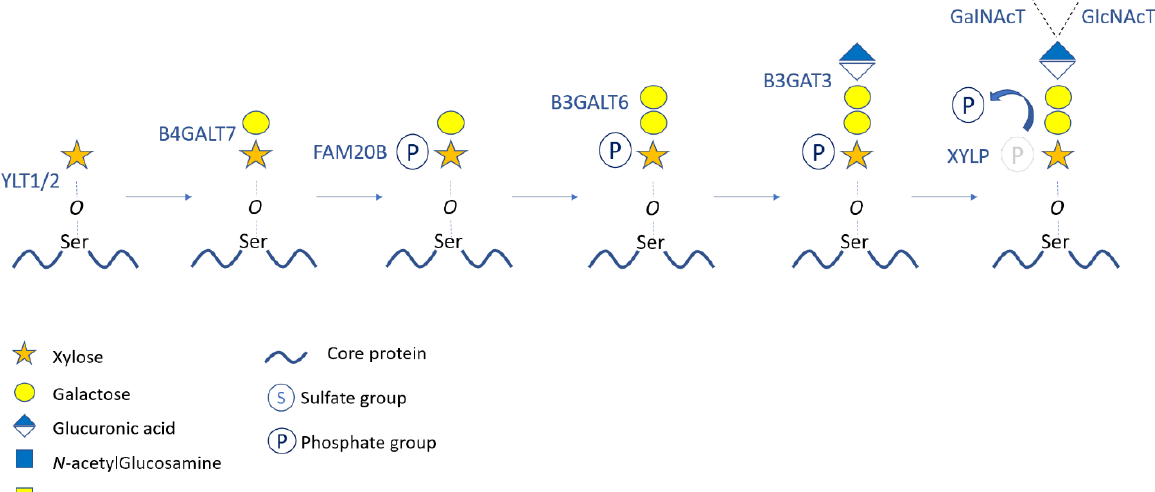
Figure 2. Biosynthesis and modifications of the tetrasaccharide linkage region. The successive steps of the initiating tetrasaccharide biosynthesis and modifications are represented with the corresponding enzymes. Transfer of the first aminosugar of CS or HS chains is also illustrated. The transient phosphorylation of the xylose occurs after the first Gal addition and is removed before the first aminosugar transfer. Enzyme abbreviations: XYLT: Xylosyltransferase; B4GALT7: β -4- galactosyltransferase7; FAM20B: Family with sequence similarity 20B; B3GALT6: β -3- galactosyltransferase6; B3GAT3: β - 3-glucuronyltransferase3; XYLP: xylose phosphatase; GalNAcT: N-acetylgalactosaminyltransferase; GlcNAcT: N-acetyl- glucosaminyltransferase.